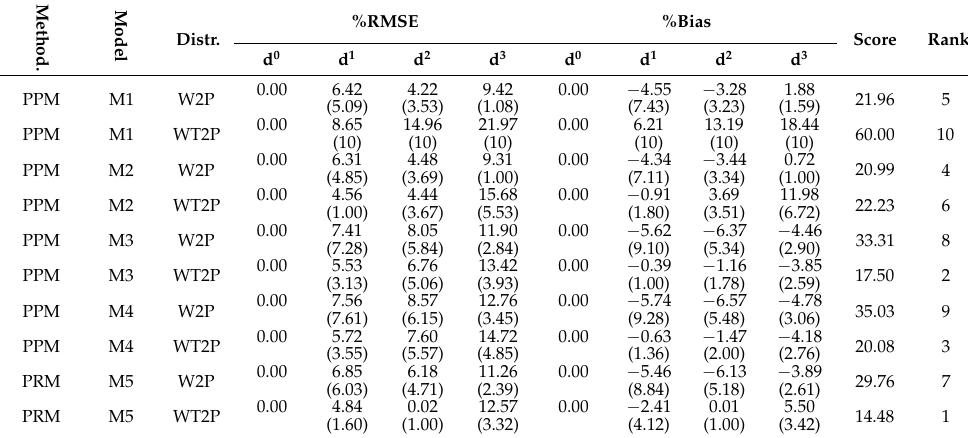
Table 5. Evaluation of the considered methods and functions applied to the fitting